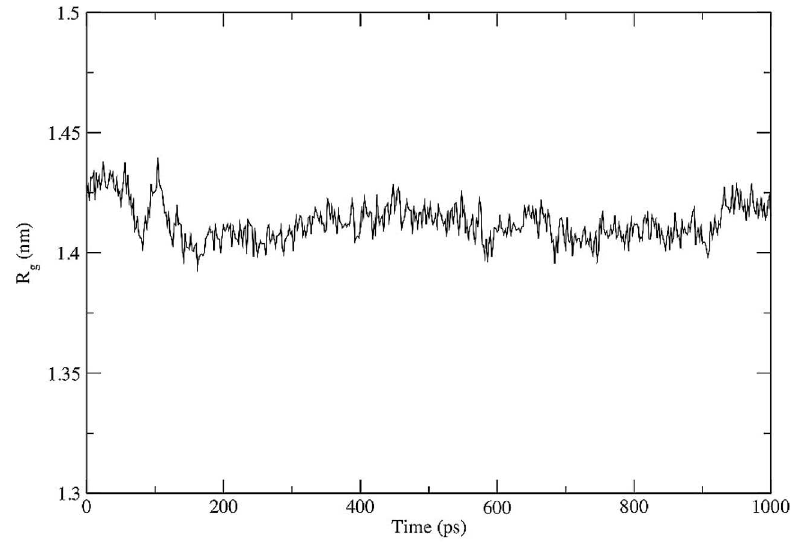
Figure 10. The radius of gyration of a protein – a measure of its compactness; source – Gromascs simulation based on Lemkul